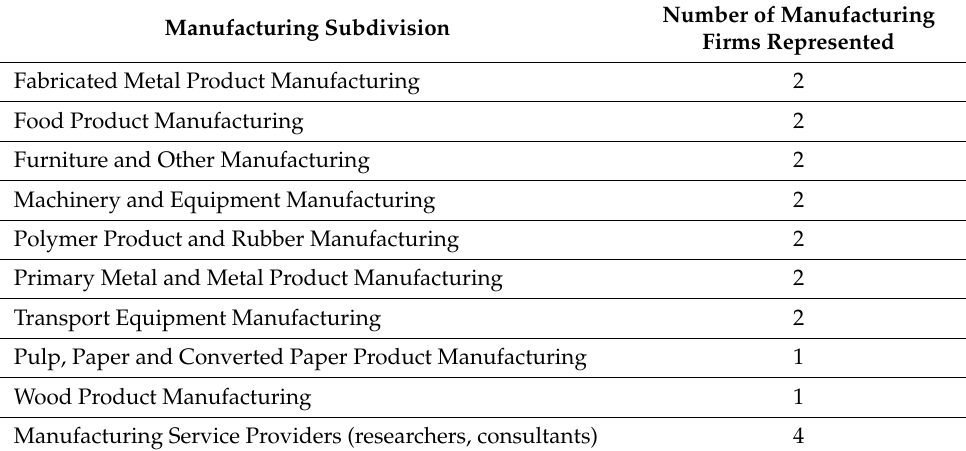
Number of Manufacturing Firms Represented